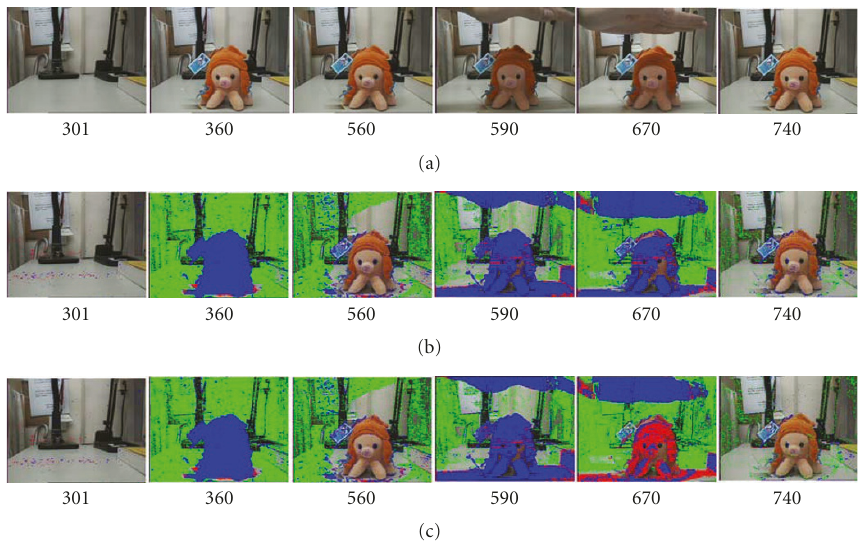
Figure 11: The results of the advantage of STCBM, where the red color means the shadow, the green color means the highlight, and the blue color means the foreground, (a) original images, (b) the results of background subtraction without STCBM, (c) the results of background subtraction with STCBM, where red indicates the shadow, green indicates the highlight, and blue indicates the